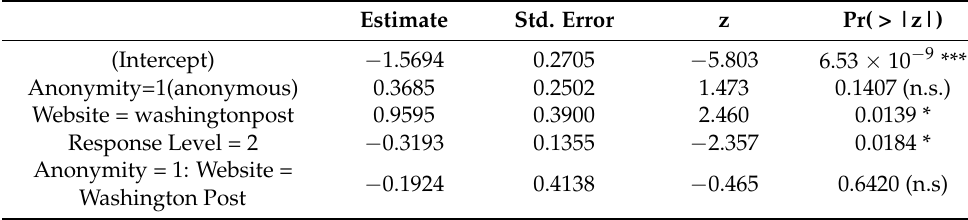
Table A3. Fixed effects.